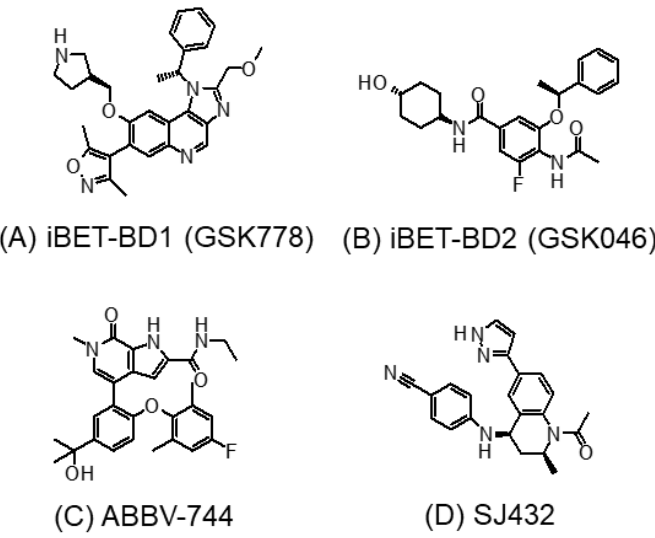
Figure 5. Chemical structures of the BD1/BD2-selective BET inhibitors discussed: ( A ) GSK778, ( B ) GSK046, ( C ) ABBV-744, and ( D ) SJ432.